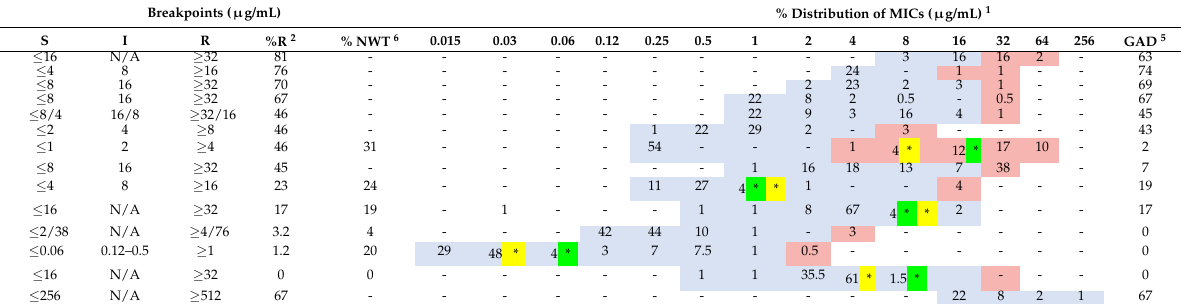
Table 3. Distribution of minimum inhibitory concentration (MIC) and resistant for S. Dublin iso- lates (n = 247) by individual drug for the NARMS panel. Highlighted areas in blue correspond to susceptible/intermediate classification, and the red highlighted area corresponds to the resistant classification. Epidemiological cut-off points (ECOFFs) for antimicrobial drugs that fulfilled criteria for this approach are marked with a yellow highlighted asterisk * (95% endpoint criteria) and a green highlighted asterisk * (99% endpoint criteria).